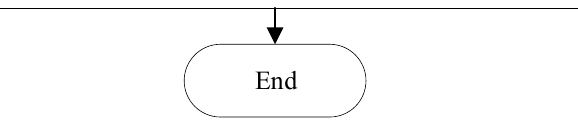
Figure 6. Fault prediction process based on a clustering algorithm.